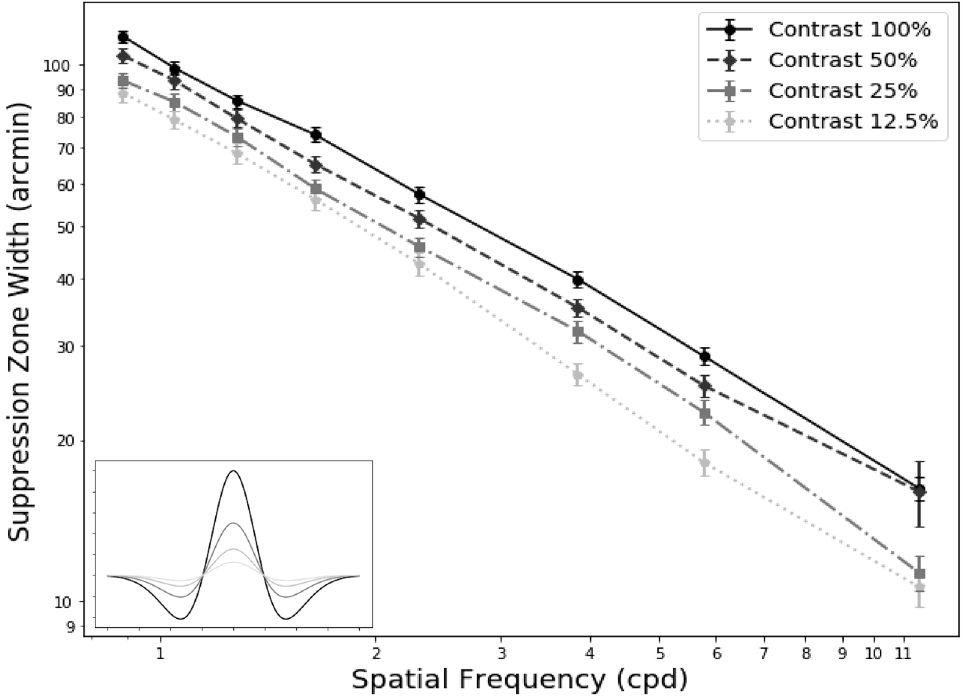
Figure 3. The reduction of suppression zone width as a function of contrast (n = 8). The solid black line (contrast 100%) is similar to the results obtained from Experiment 1A. This line is shifted downward with lower contrast. The vertical error bars represent the standard error. The lower left inset illustrates the cross-section view of the DoG at different contrast